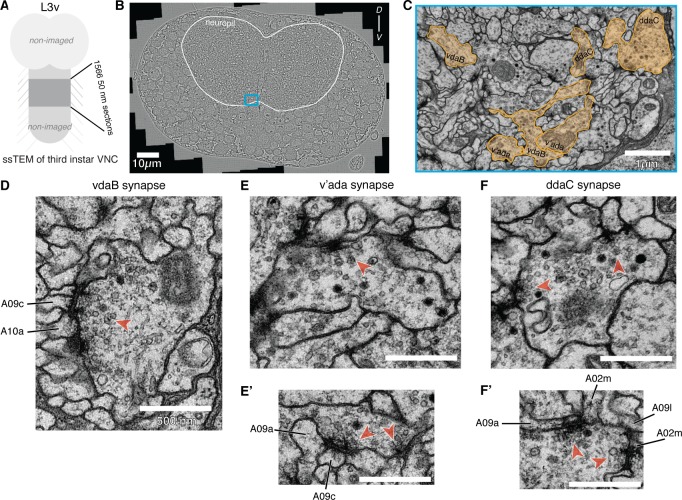
A new EM image volume from a third instar larva ventral nerve cord.(A) Schematic of the region of the third instar larva CNS sectioned and imaged for the L3v. Anterior is up. (B) A single section of L3v includes the complete neuropil (region inside white outline) and all soma (region outside white outline). Dorsal is up. (C) Ventromedial neuropile indicated in the blue outline in B. Neurite cross-sections highlighted in orange correspond to ipsilateral mdIV axons. (D–F’) Example synapses from vdaB (E), v’ada (E,E’), and ddaC (F,F’) terminals. Vesicles and pre-synaptic specializations highlighted by the red arrowhead. Post-synaptic neurons from LNs described in the main text are highlighted. Note the combination of small and dense core vesicles found in all three mdIV neurons.